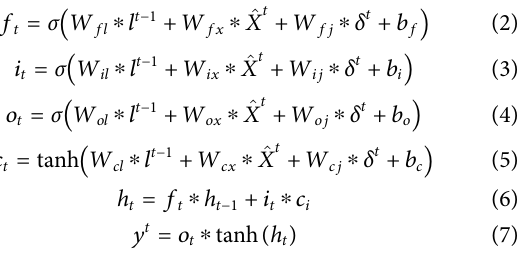
Algorithm 1. Long-term lung lesion prediction algorithm for